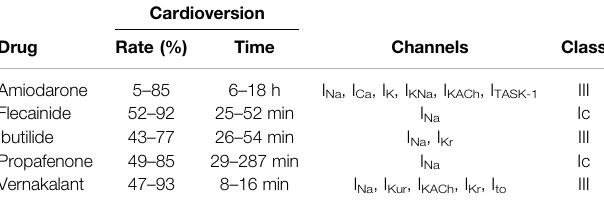
TABLE 1 | Overview of recommended antiarrhythmic drugs for acute pharmacological cardioversion by the ESC with their rate and time of cardioversion, targets and class after Vaughan